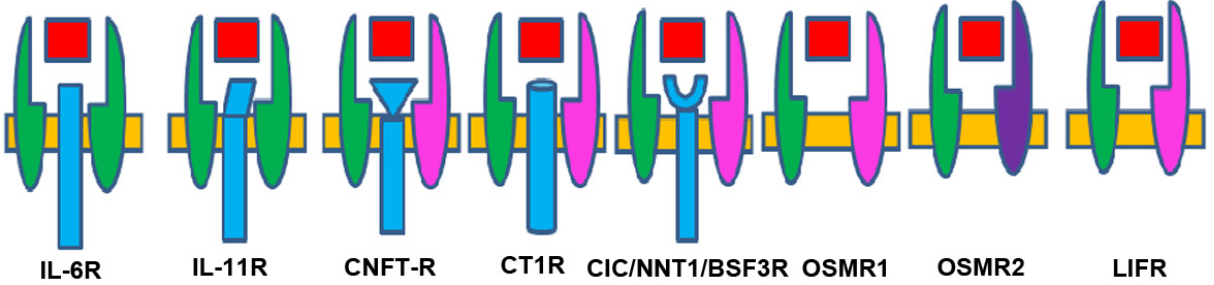
Figure 2. IL-6 family cytokines and their receptors Receptor complexes are composed of the signaling subunits gp 130 (green), LIF- R (pink) and OSM-R (lilac) and specific ligand binding receptors. (For IL-6, IL-11R, CNTF-R, CT-1R and CIC/NNT-1/BSF-3-R). IL-6 and IL-11 signal via a homodimer of gp 130 whereas ciliary neurotrophic factor (CNTF), cardiotrophin 1 (CT-1), and novel neurotrophin 1 (NNT-1) use a heterodimers of gp 130 and LIF-R. Leukemia inhibitory factor (LIF) and oncostatin M (OSM) do not use specific binding receptors. Binding of IL-6 cytokines will activate Janus Kinase-Signal Transducer, Activator of Transcription (JAK-STAT) and Mitogen-Activated Protein Kinase (MAPK)